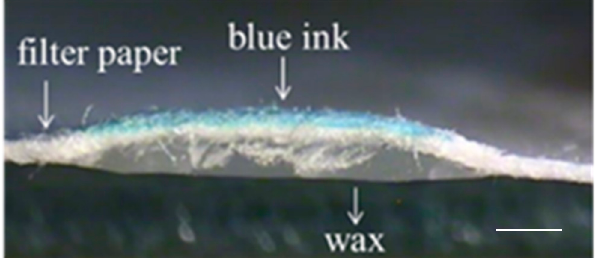
Figure 4. The cross-sectional view of the embossed filter paper with ink solution wicking through the channel. Scale bar: 1 mm.